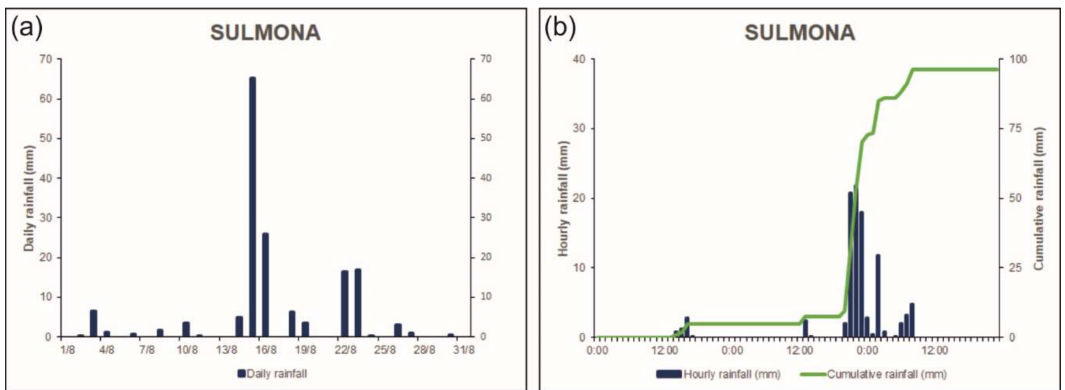
Figure 11. Sulmona pluviometric station: ( a ) Daily rainfall in the month of August 2018; ( b ) hourly and cumulative rainfall during the event of 15–16 August 2018.